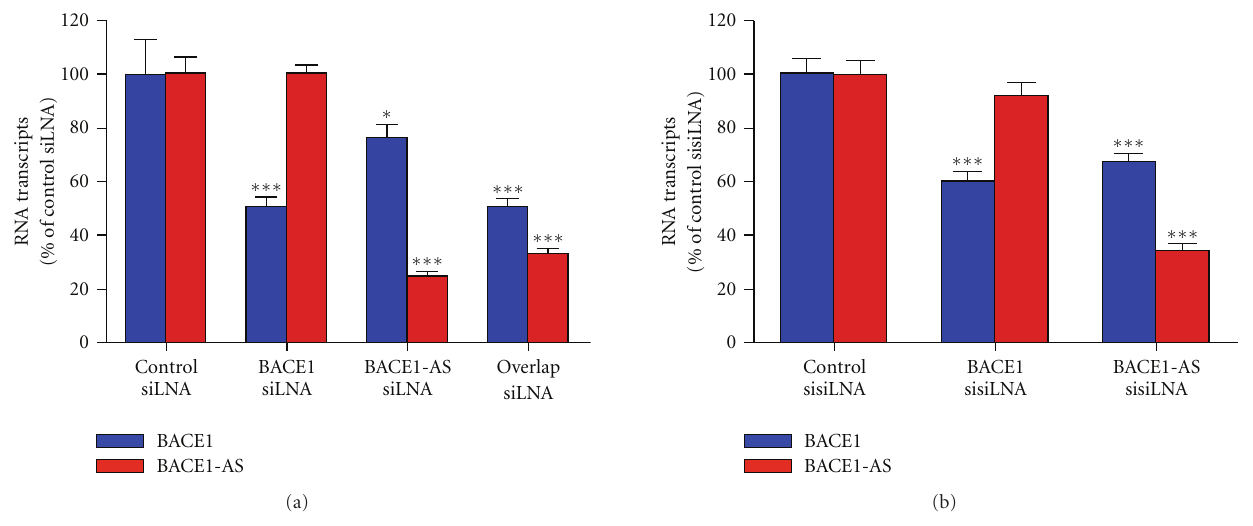
Figure 4: E ff ects of siLNA and sisiLNA in BACE1 and BACE1-AS RNA levels in vitro . To test the ability of siLNAs (a) and sisiLNAs (b) on BACE1 and BACE1-AS, we performed a study in mouse neuroblastoma N2a cells in vitro . Selective targets against BACE1-AS transcript were able to significantly knockdown not only BACE1-AS but also BACE1, supporting the proposed concordant regulation of BACE1 mRNA by